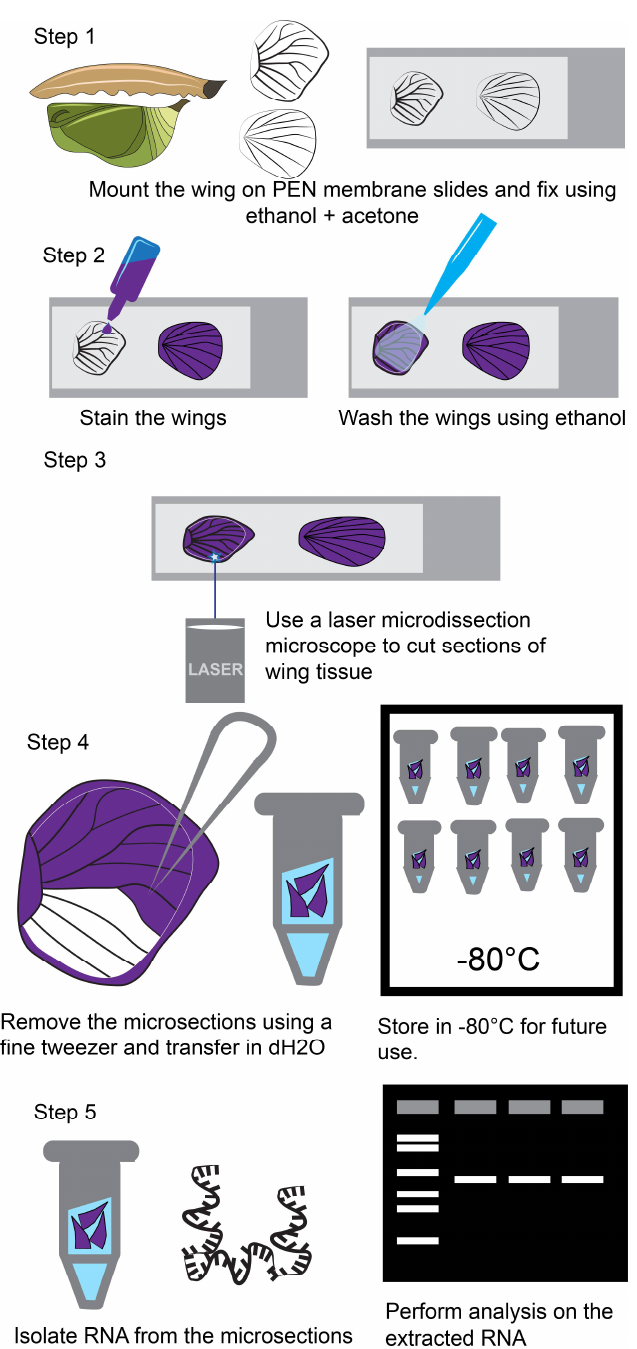
Figure 1. Steps involved in the microdissection of butterfly larval and pupal wing tissue. Step 1 involves the transfer of the wing tissue onto the PEN membrane slides and fixation using ethanol and acetone. Step 2 involves staining the wings with Histogene solution and performing washes with ethanol. Step 3 involves laser microdissection using a Zeiss PALM microbeam. Step 4 involves isolation of the microsections from the dissected microtissues using a pair of fine tweezers and transfer of microsections into molecular grade water. Afterwards, the tissues can be stored at − 80 ◦ C. Step 5 involves extraction of RNA from the microdissected tissues and testing the integrity of the